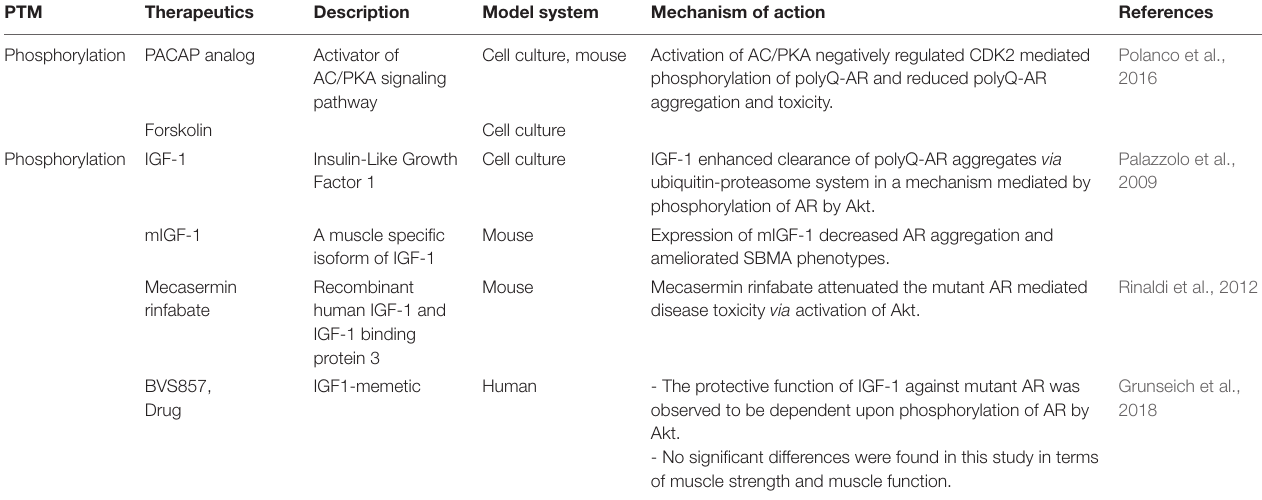
TABLE 2 | Therapeutics targeting PTM as treatment strategies for